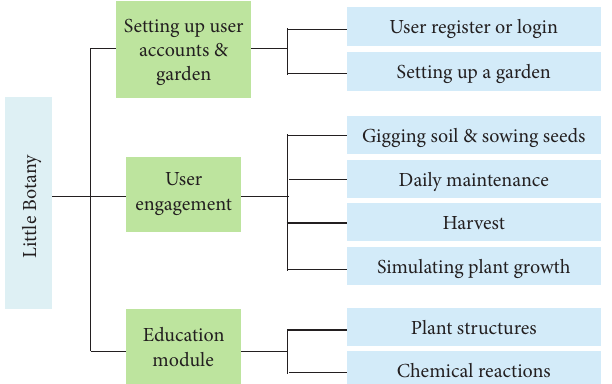
Figure 7: Little Botany’s functionality diagram.